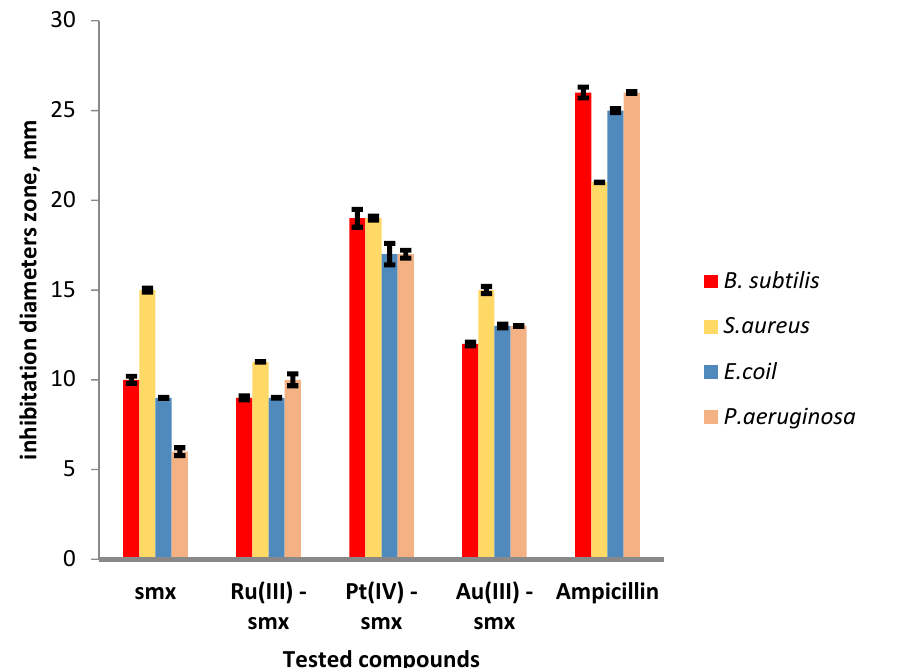
Figure 6. Statistical interpretation for biological action of sulfamethoxazole and its metal complexes. Table 8. Results of Anticancer activity of the prepared